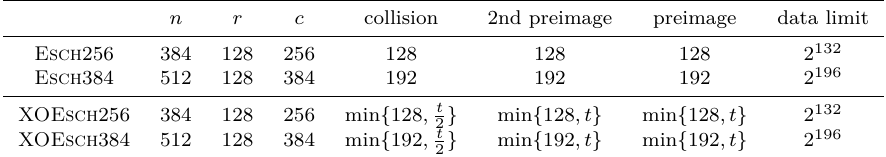
Algorithm 3 pad